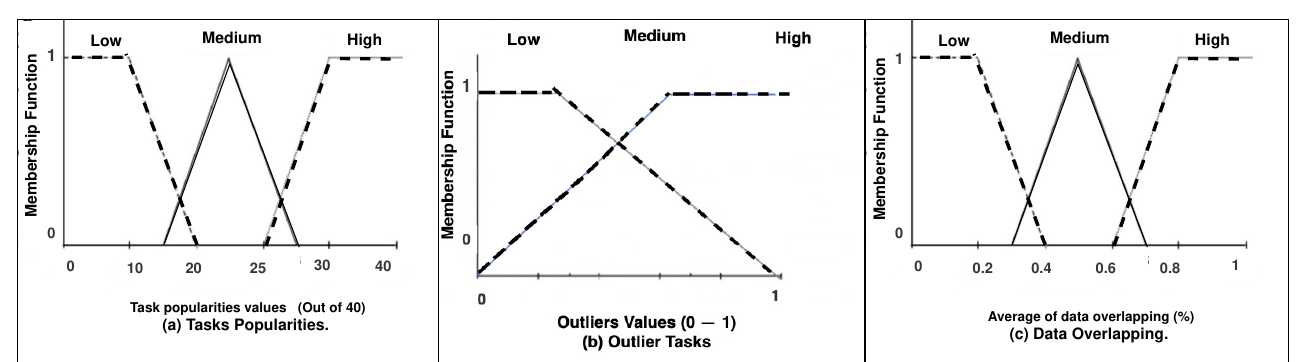
Figure 2. Implementation of FL on our three